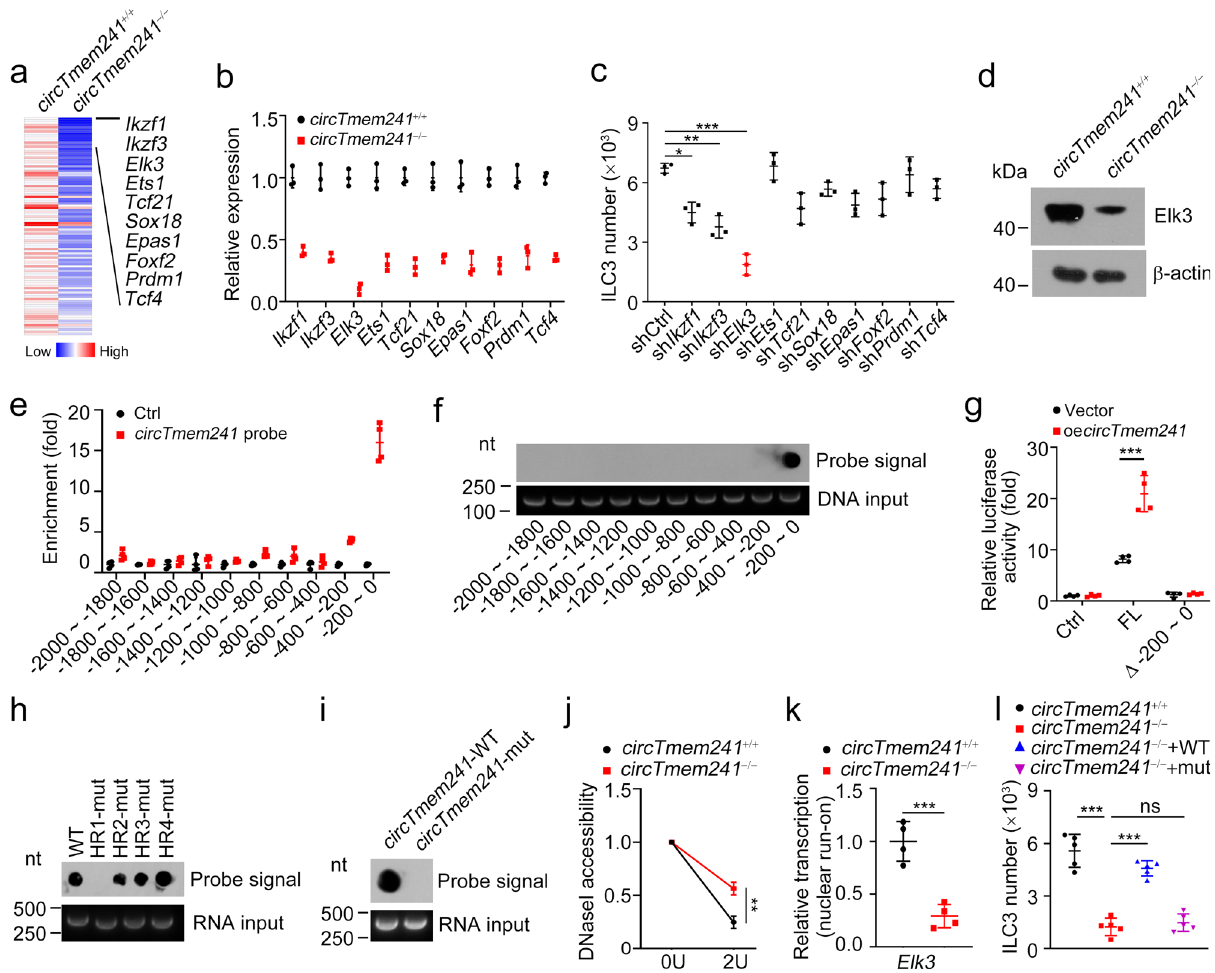
Fig. 4 | CircTmem241 enhances Elk3 expression. a Heatmap of top ten down- regulated TFs in circTmem241 − / − ILCPs versus circTmem241 +/+ ILCPs by tran- scriptomeanalysis. b Relativeexpressionlevelsoftop10TFsin circTmem241 +/+ and circTmem241 − / − ILCPswereanalyzed by qRT-PCR. Fold changeswerenormalized to endogenous Gapdh . n =3 biological independent experiments. c Top 10 down- regulatedTFswereknocked downinILCPswereanalyzedbyFACS. n =3biological independentexperiments. d Elk3proteinlevelsin circTmem241 +/+ or circTmem241 − / − ILCPsbywesternblotting. e Enrichmentof circTmem241 on Elk3 genepromoterwas analyzed by CHIRP assay. CircTmem241 probe was biotin labeled. n =4 for each group. f Enrichment of circTmem241 on Elk3 gene promoter was further validated by dot blot. g Luciferase reporter assay was performed to validate circTmem241 functionon Elk3 transcriptionactivation.FL,full-length(represent − 2000~0region upstream Elk3 transcriptional start site). n =4 for each group. h , i CircTmem241